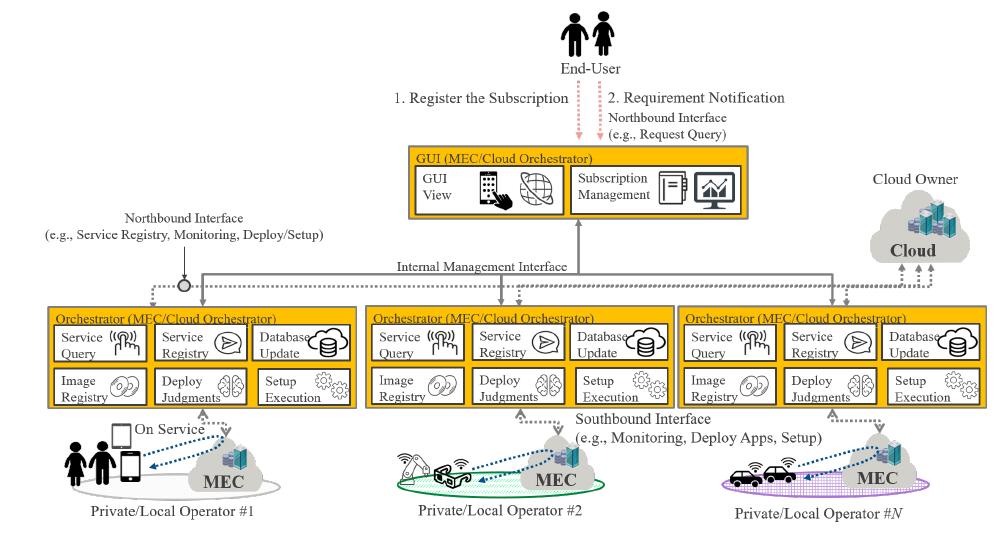
Figure 8. Illustration of the Distributed Type of an MEC/Cloud